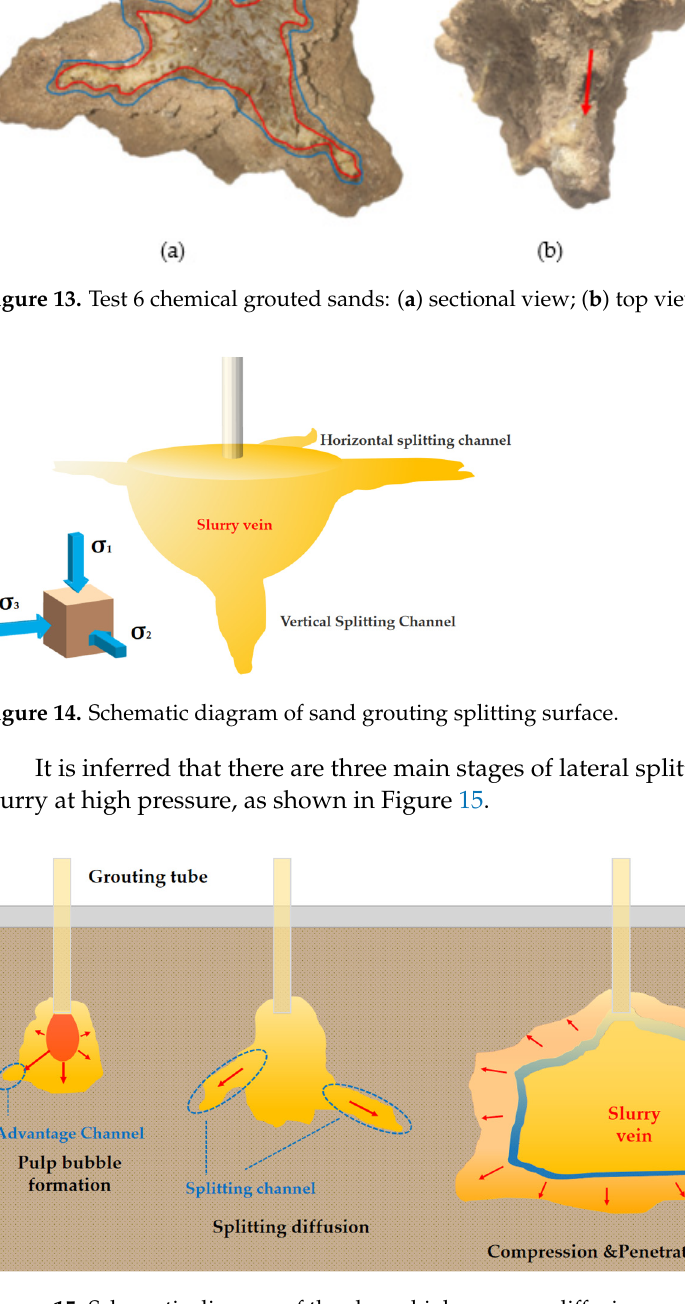
Figure 15. Schematic diagram of the slurry high ‐ pressure diffusion process.